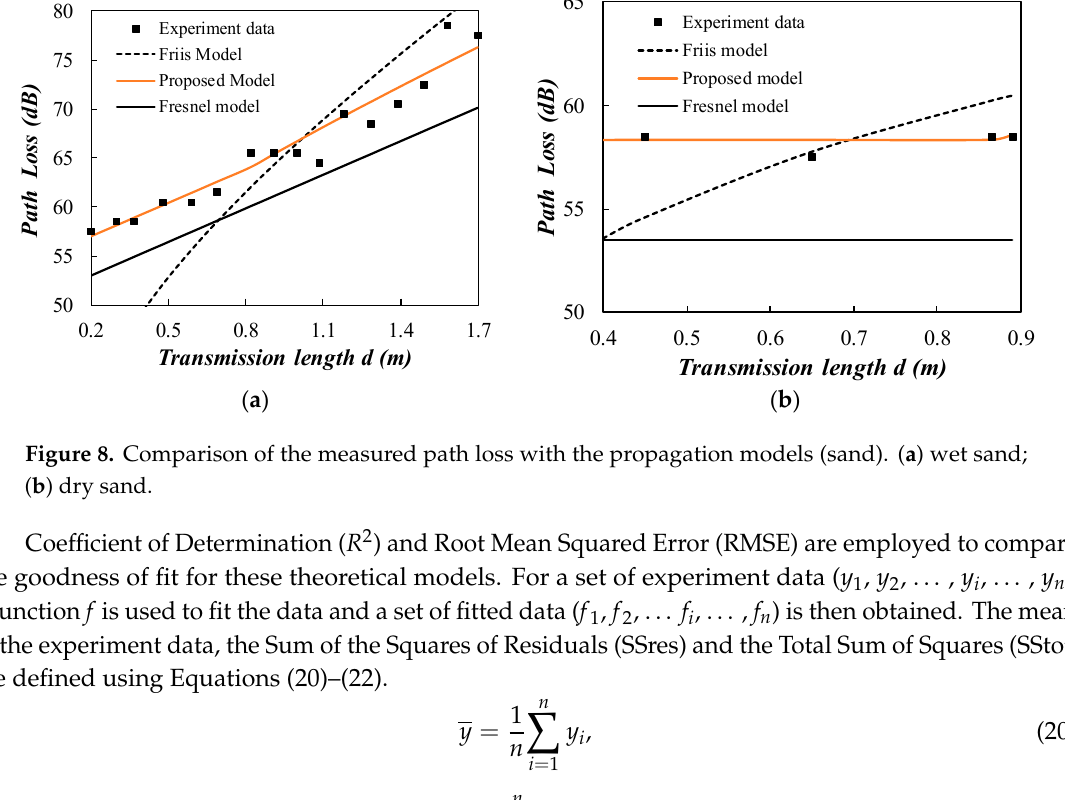
Figure 7. Comparison of the measured path loss with the propagation models (clayey silt). ( a ) group 1; ( b ) group 2.